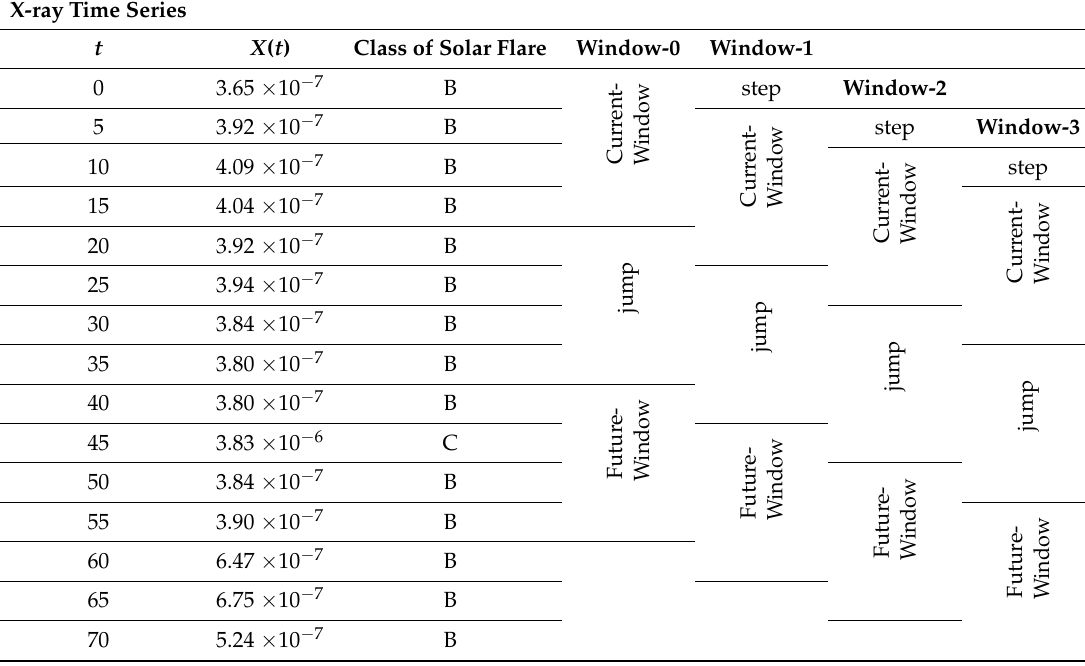
Table 2. Sliding window evolution performed in the execution of